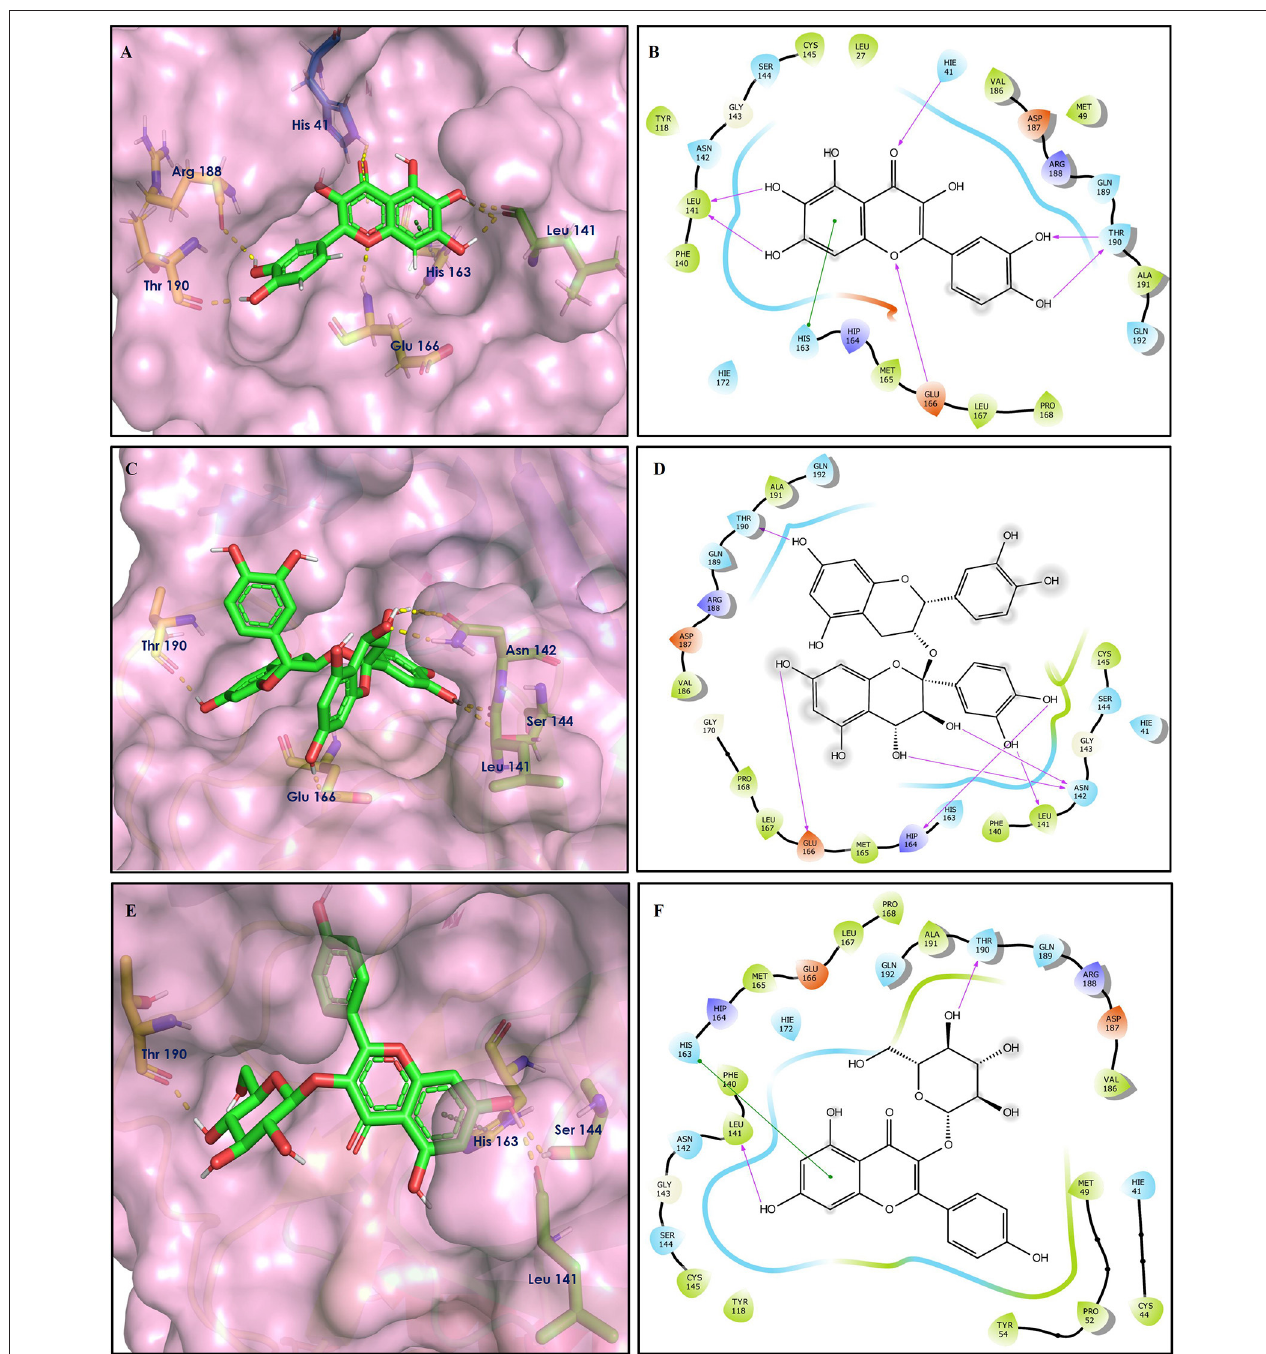
FIGURE 4 | Docking interactions of compounds (8, 9, 10 : A–F) in the active sites of Mpro. (A,C,E) 3D-binding mode of compounds 8 , 9 , and 10 with Mpro active site, respectively. Ligands are shown as green sticks, Mpro residues are shown as atom type color sticks, hydrogen bonds formed between ligands and receptor are depicted as yellow dotted lines, π - π stacking interaction is indicated as green dotted lines; (B,D,F) 2D-ligand interaction diagram of compounds 8 , 9 , and 10 with Mpro active site, respectively.